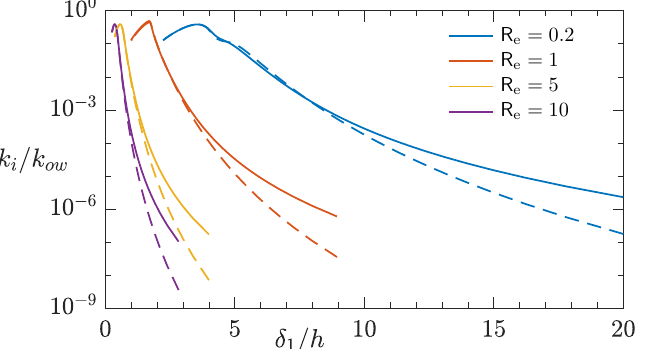
Figure 4. k i / k ow as a function of δ 1 / h with varying R e . For each R e , Π 1 = 100 (solid), ∞